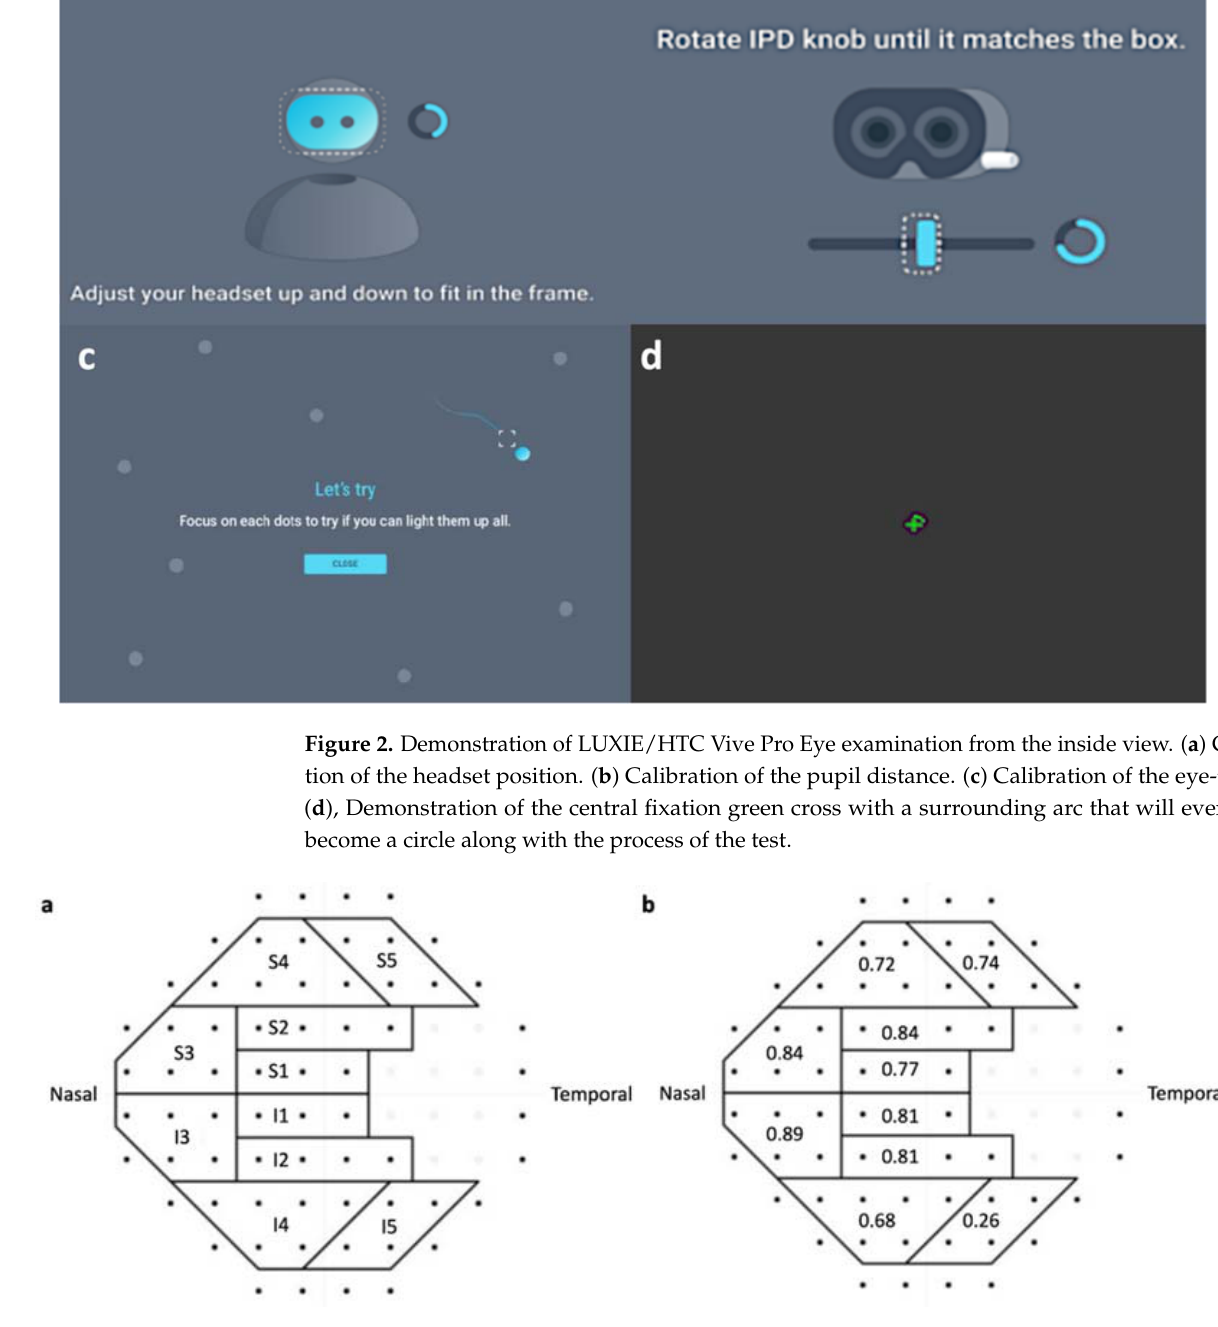
Figure 3. ( a ) The glaucoma hemifield test (GHT) sectors and its corresponding locations on central 30° visual field grids. ( b ) Correlations of GHT sectors between LUXIE and Humphrey Field Ana ‐ lyzer 3.